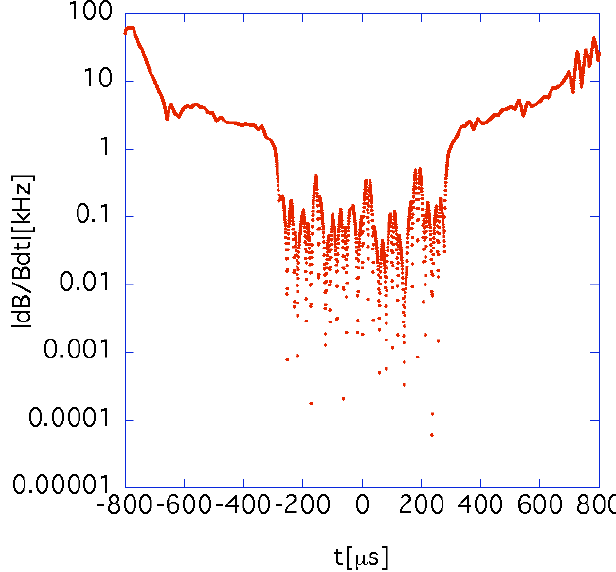
FIG. 26. (Color) The red and blue points represent Q value with j and without the effect of the mutual inductance, respectively. value for the j th mode had been enhanced by the The Q FIG. 27. (Color) The rate of change of magnetic flux j dB=Bdt j j inductance matrix L being diagonalized, when compared to for the ‘‘measured’’ field pattern that is given by the left of ij the case where the mutual inductance is neglected. Fig.